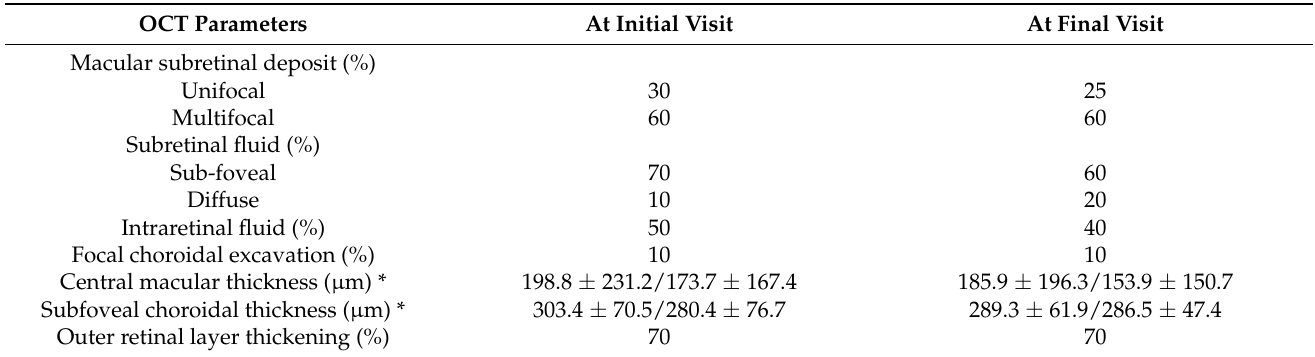
Table 2. Spectral-domain optical coherence tomography parameters of 20 eyes with autosomal recessive bestrophinopathy at initial and final visits.